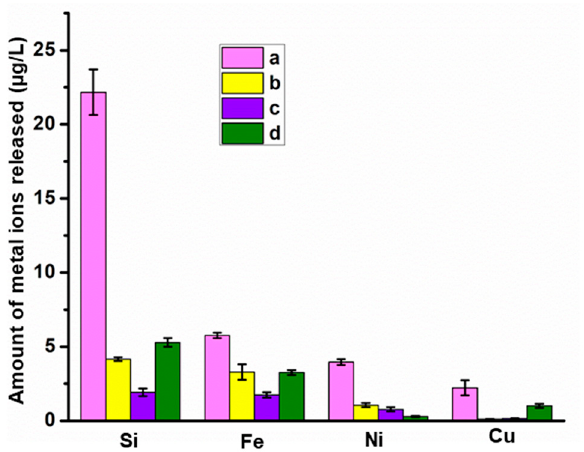
Figure 6. ICP MS analysis of metal ions leached of a—OB, b—OB-POX, c—OB-POX/L-Trp, d—OB- POX/D-Trp incubated in phosphate-buffered saline at pH 7.2 on day 7. POX/D-Trp incubated in phosphate-buffered saline at pH 7.2 on day